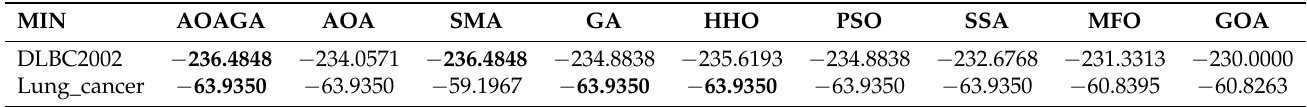
Table 12. Real Application: Minimum of the fitness value.